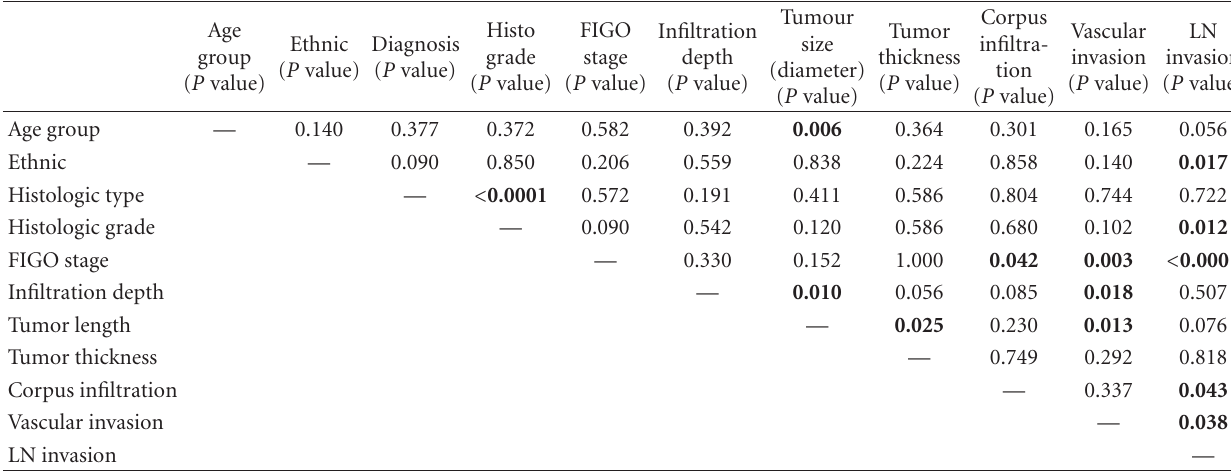
∗ Calculated using Chi-square. Table 3: Interrelationship ∗ between clinicopathological parameters in patients with adenocarcinoma of endometrium (EMA).